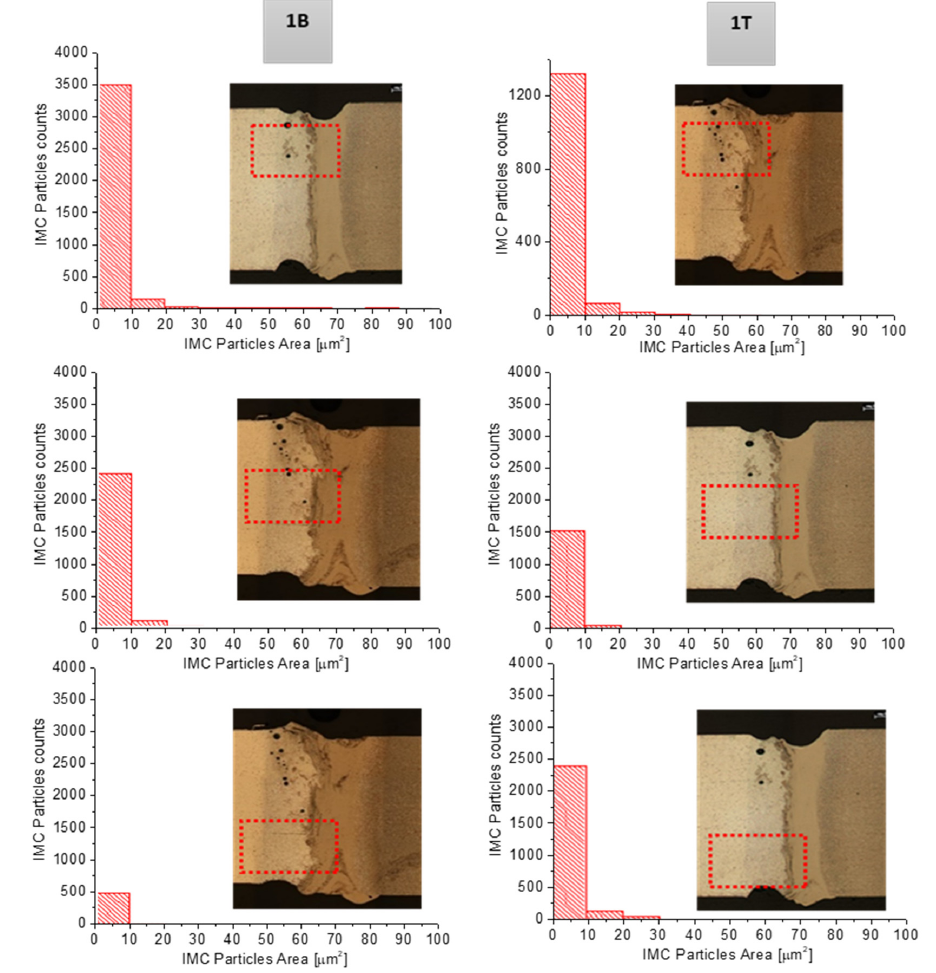
Figure 9. IMC particles distribution along the thickness of joints 1T and 1B.